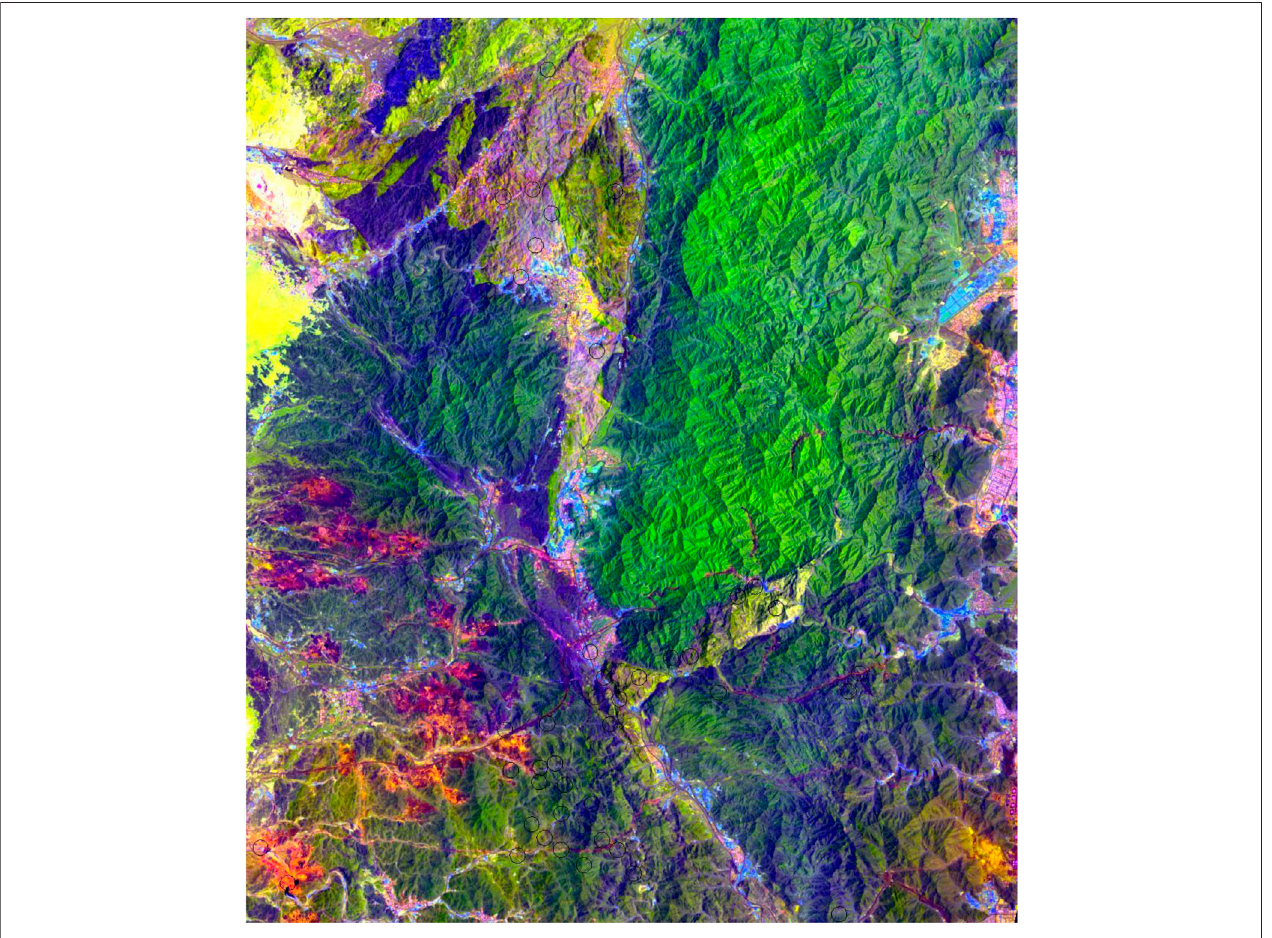
FIGURE 14 | False color composite images of principal components PC1, PC2, PC3 displayed in R-G-B for the study area. The dark purple colors pixels represent gabbro, peridotite is displayed in green colors, and metamorphic sole is shown in yellowish green. The locations of copper is shown in black